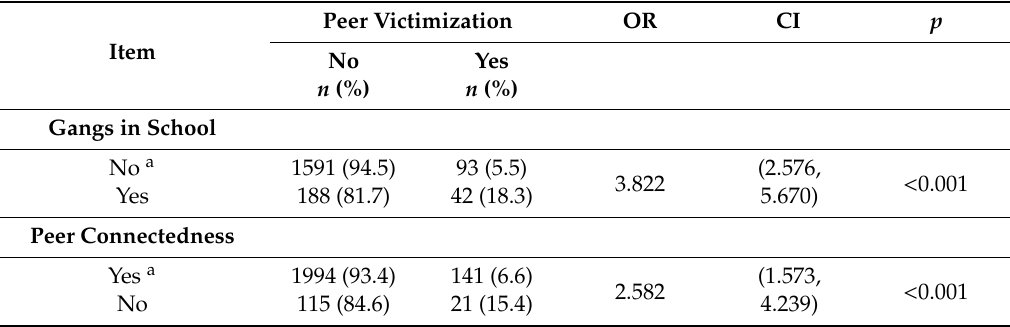
a Indicates Referent.